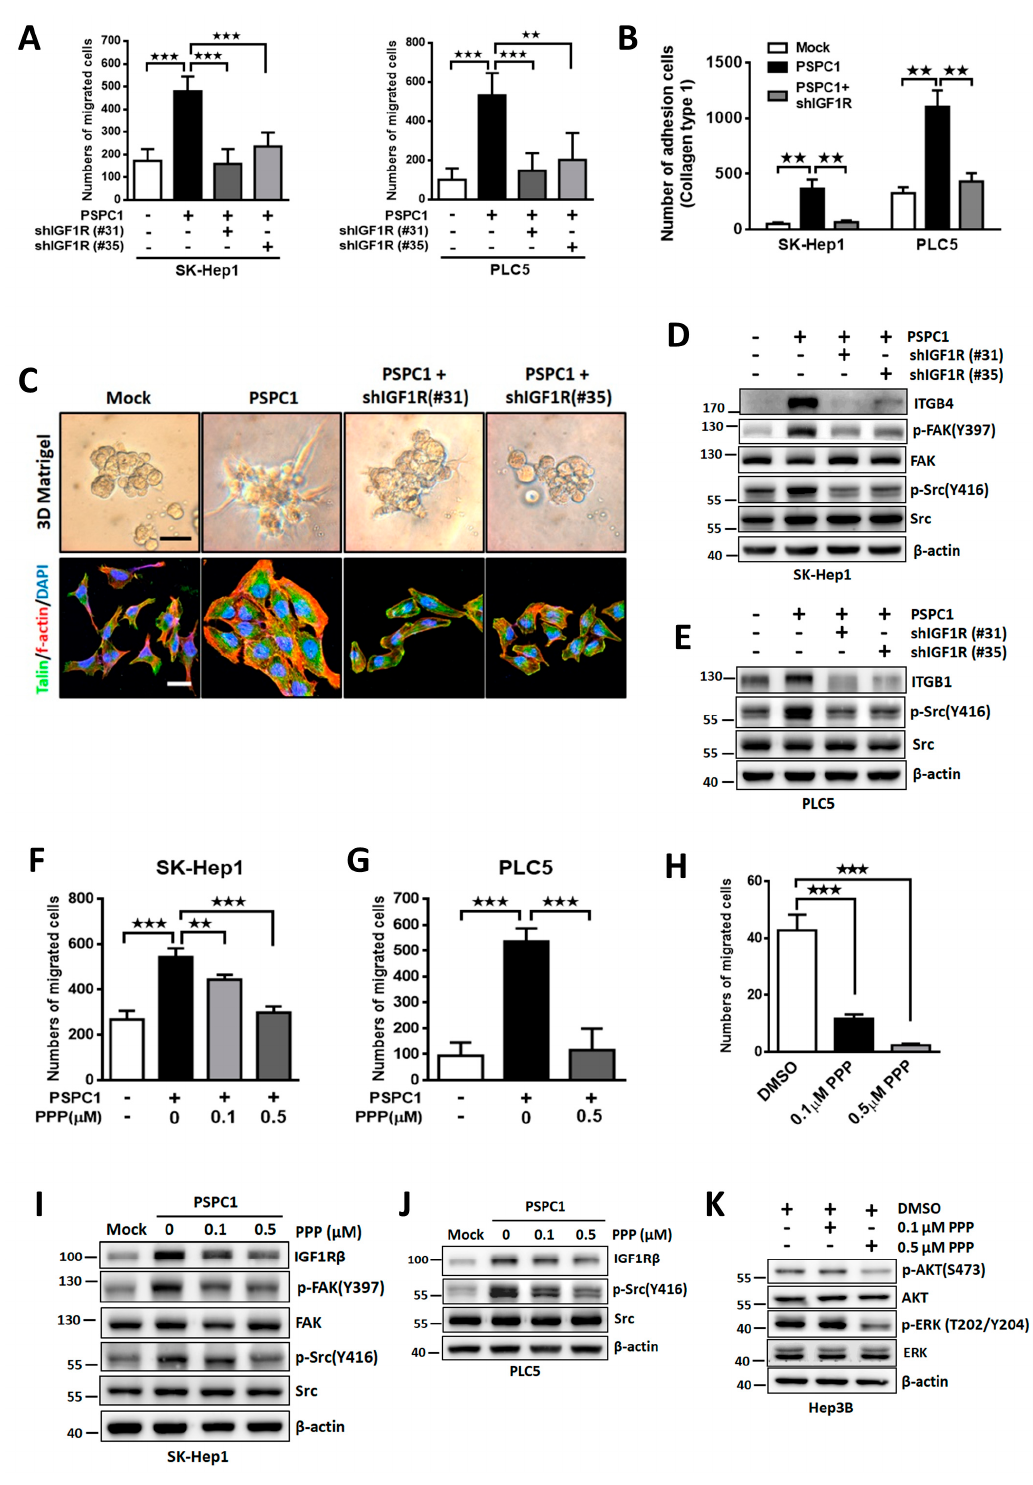
Figure 4. PSPC1 modulates cell adhesion and motility by activation of IGF1R signaling. Stable depletion of IGF1R by shRNAs in PSPC1-overexpressing SK-Hep1 and PLC5 cells reduced cell migration using Boyden chamber assay ( A ) and cell adhesion assay on type I collagen ECM ( B ). ( C ) PSPC1-induced invasiveness (top) and stress fiber assembly (bottom) were assessed by using 3D-Matrigel assay and f-actin staining, respectively, in PSPC1-overexpressing SK-Hep1 cells with and without depletion of IGF1R. ( D , E ) Knockdown of IGF1R suppressed PSPC1-activated p-FAK (Y397), p-Src (Y416), integrin β 4, and integrin β 1 in HCC cells detected by Western blotting assay.